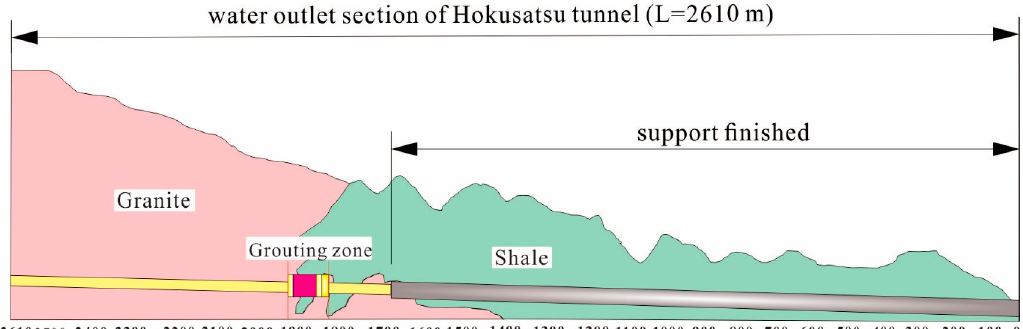
Figure 3. Simplified geological profile along the tunnel axis.